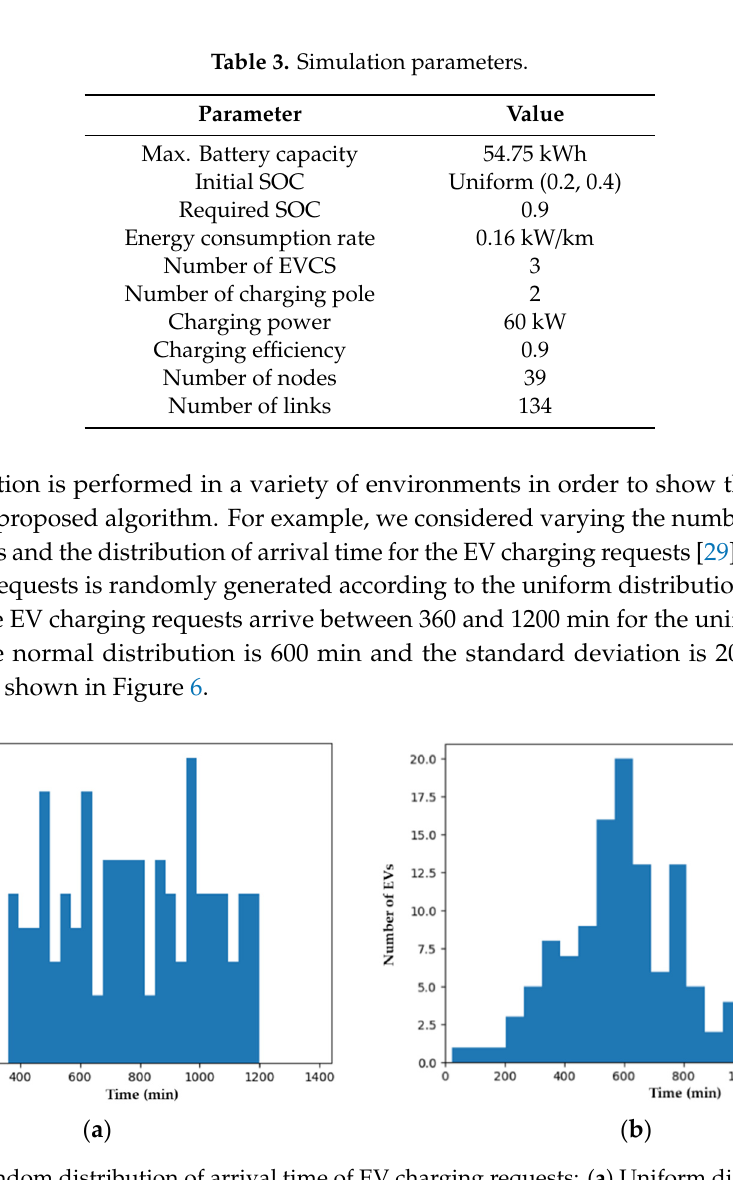
Figure 6. Random distribution of arrival time of EV charging requests: ( a ) Uniform distribution; ( b ) Normal distribution.